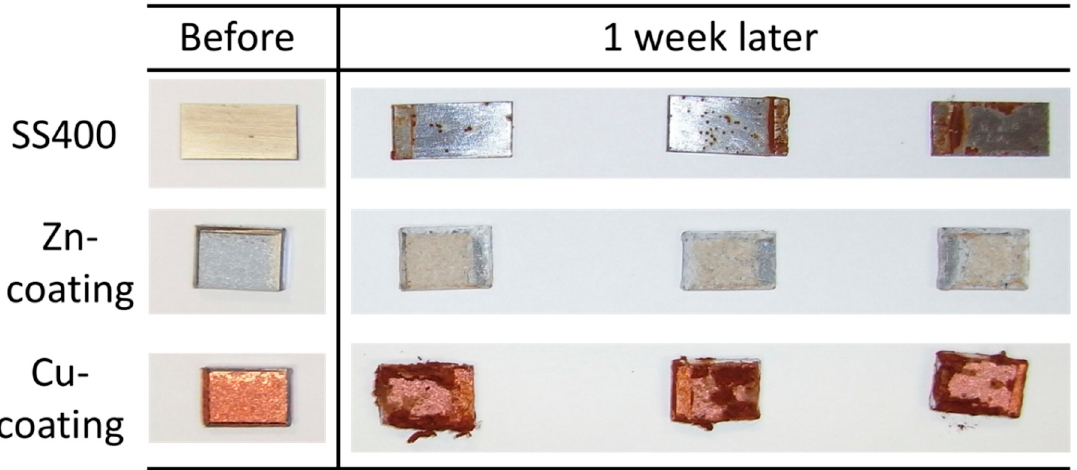
Figure 11. Optical microscopy images of the surface of the LBR-immerged coupons. Each white bar represents 5 mm. SEM analysis showed that areas that bulged outward were observed on the surfaces of SS400, Cu- and Zn-coated coupons post-water-immersion testing (Figure 12). Since SS400, a carbon steel, consists of carbon and steel, these bulging sediments were obviously iron oxides (i.e., corroded iron products). In order to confirm whether or not the bulging areas arose from iron oxides or other compounds, an element mapping was conducted. On the surface of the Cu-coated coupons, areas with iron corresponded to areas with oxygen and silicon (Figure 13). Meanwhile, on the surface of the Zn-coated coupons, zinc areas corresponded to areas with oxygen and silicon (Figure 14). These results indicate that bulging areas of the surface of the Cu-coated and Zn-coated coupons were iron oxides and zinc oxides, respectively. Interestingly, these oxides were corrosion products. According to ionization tendency, zinc is more easily ionized than iron, while copper is barely more ionized than iron. Therefore, Zn-coated coupons and Cu-coated coupons will cause mainly zinc corrosion and iron corrosion, respectively. Indeed, detected corrosion products reflected the differences in ionization tendency between zinc and iron, or copper and iron. In addition, Kuroda et al. reported that silicon was detected with calcium in biofilms in cooling water systems [21]. Considering that silicon and calcium are derived from tap water, biofilms would be formed on the corroded sites of the Cu-coated coupons, Zn- coated coupons, and SS400 coupons by tap water and air-trapped bacteria. Cu-coated